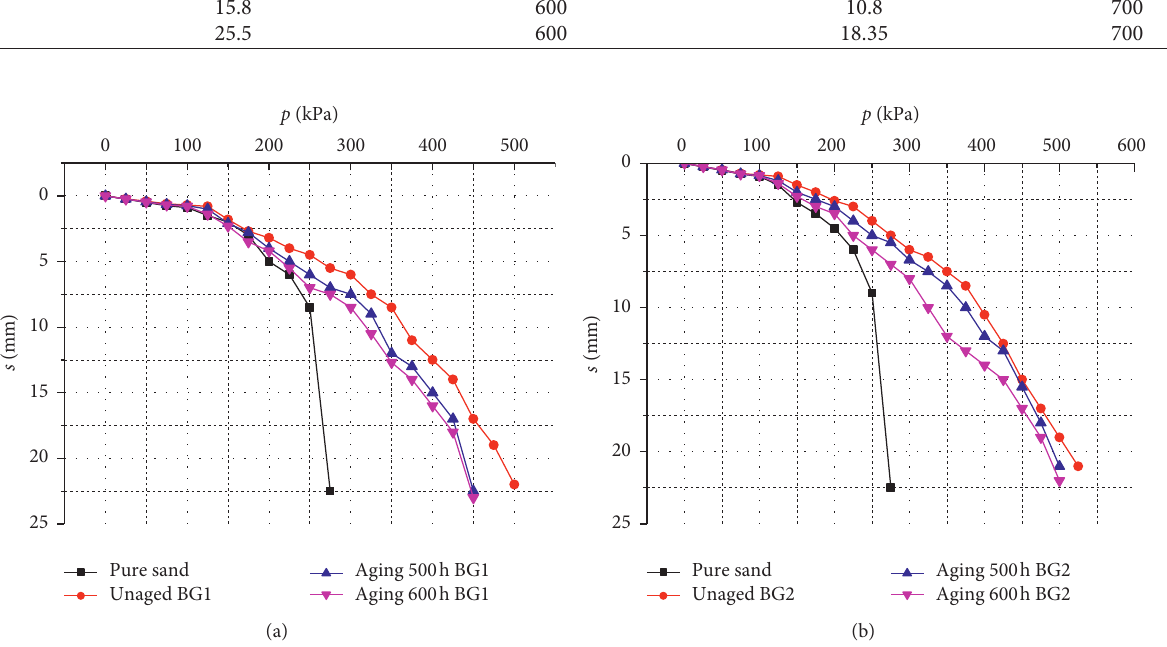
Figure 11: Load-settlement (P-S) curve of geogrid reinforced sand considering aging effect. (a) BG1. (b)